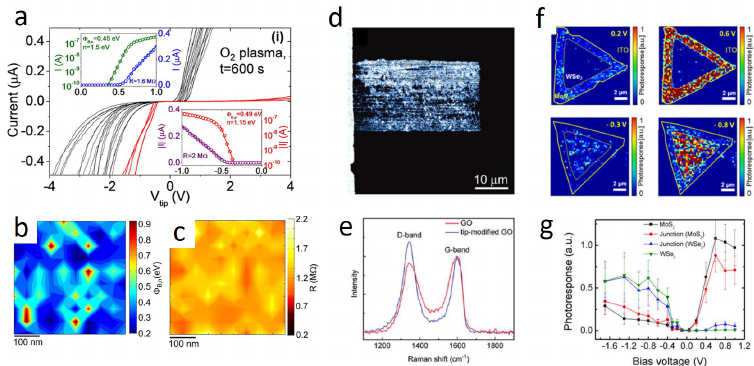
Figure 4. ( a ) Arrays of local current-voltage (I-V tip ) characteristics measured by Conductive Atomic Force Microscopy (C-AFM) on MoS2 subjected to O 2 plasma. Insets in (a) show fittings of representatives curves on linear- and semilog-scale to extract the local Schottky barrier height ( Φ B,n ) and the series resistance (R); ( b , c ) Two-dimensional (2D) maps of the local Φ B,n and R (adapted from [90]); ( d ) C-AFM current map of a tip-modified rectangular region of a few-layer GO film with a top-contact gold electrode on the left side (current range 50 nA); ( e ) Raman spectra obtained on modified and unmodified GO (adapted from [92]); ( f ) Spatially resolved photoresponse maps and derived plot ( g ) of a WSe 2 − MoS 2 heterostructure crystal in both forward (0.2 and 0.6 V) and reverse voltage ( − 0.3 V and − 0.8 V) regimes under illumination of λ = 550 nm. The photoresponse maps are generated by subtracting a photocurrent map under illumination (Photoconductive Atomic Force Microscopy (PC-AFM) map) from a dark current map (C-AFM map), and normalized by the incident laser power at a selected wavelength. (adapted from